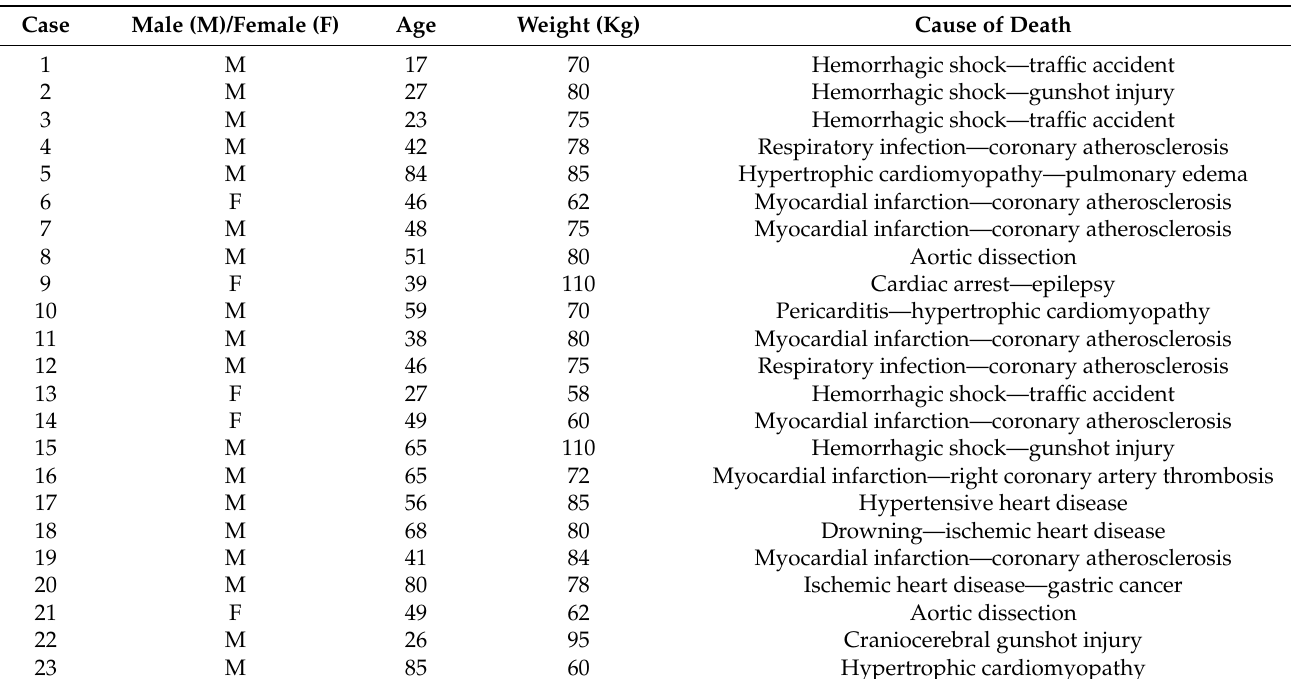
Table 2. Case histories.